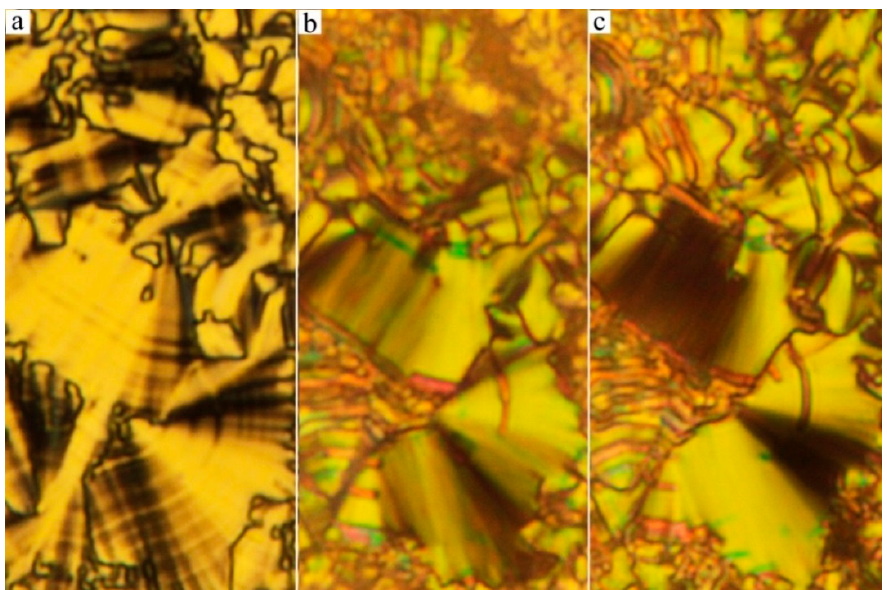
Figure 3. Textures in the SmC A P A phase of Id at T = 96 °C: ( a ) without the applied electric field, ( b ) and ( c ) under the field of about ±10V/ μ m, with opposite polarity, respectively. Polarizers are oriented along the edge of the photo, the width of each photo corresponds to about 100 μ m.